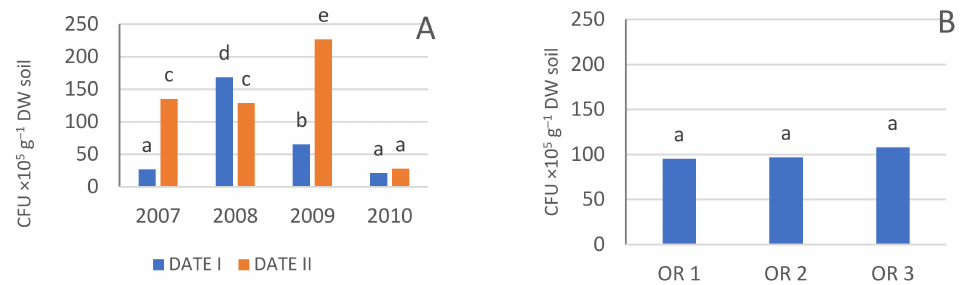
Figure 5. Total number of bacteria in 2007–2010: ( A )—depending on the year and date of sampling; ( B )—depending on the